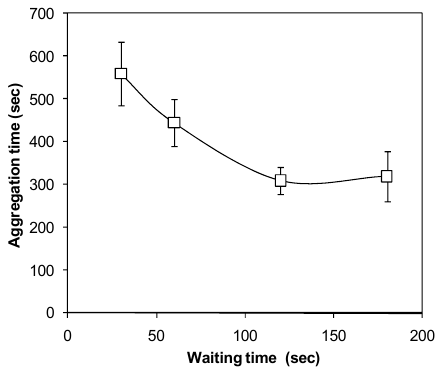
Fig. 8. Aggregation time for six AMiRs as a function of waiting time